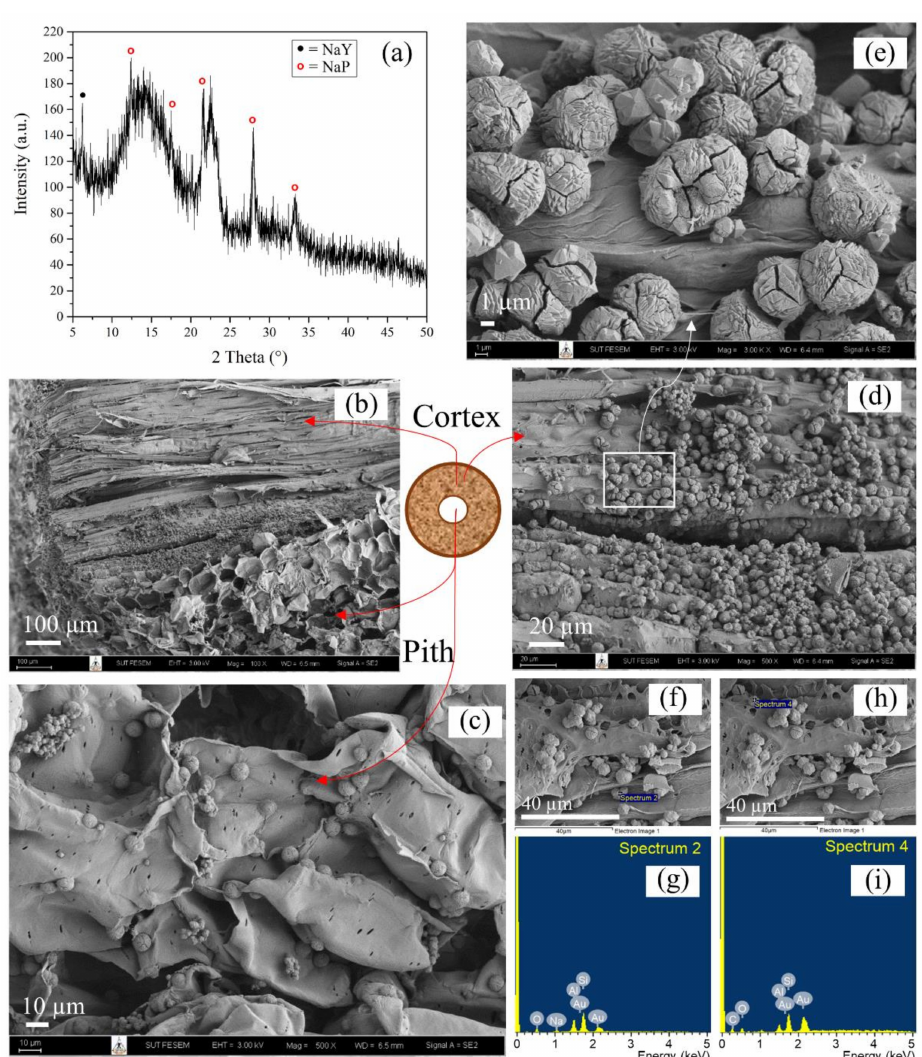
Figure 4. ( a ) XRD patterns, ( b ) SEM images Lead tree wood-zeolite composites of untreated wood with sonication (NRS) ( c ) at pith, ( d , e ) at cortex, and EDS points analysis spectrum of ( f , g ) polyhedral and ( h , i ) three pointed cracked spherical morphology,